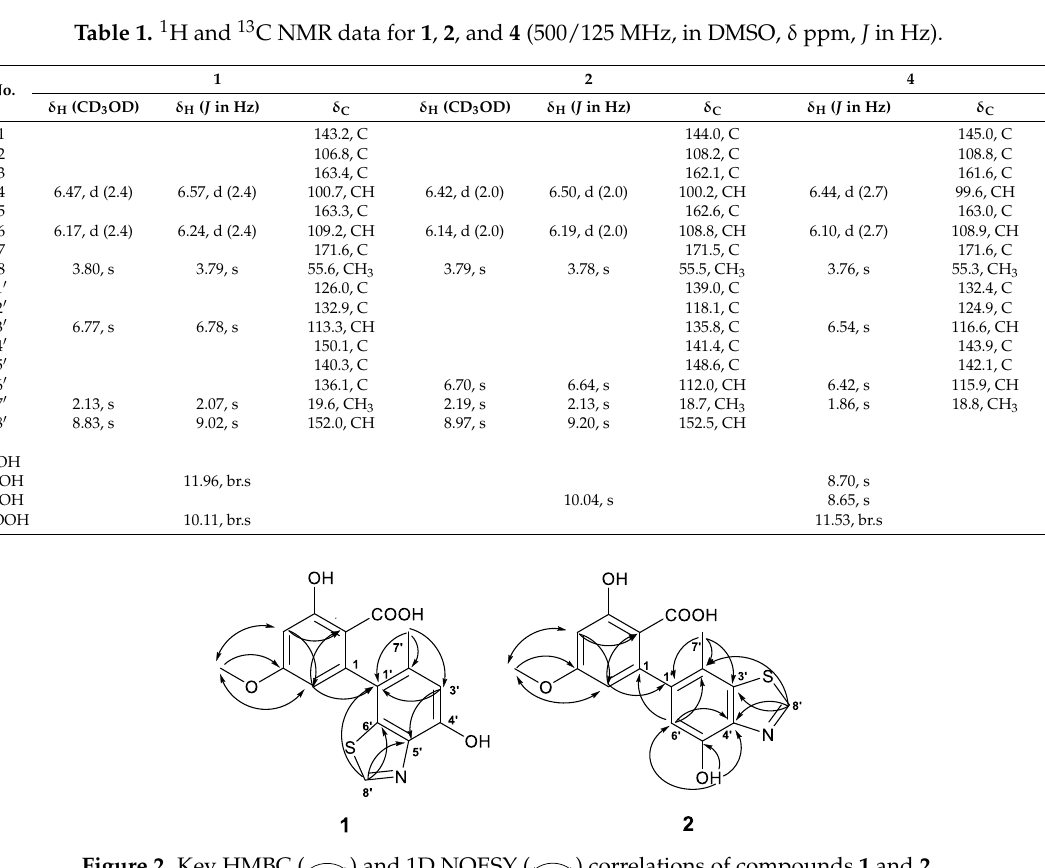
Figure 2. Key HMBC ( ) and 1D NOESY ( ) correlations of compounds 1 and 2 .